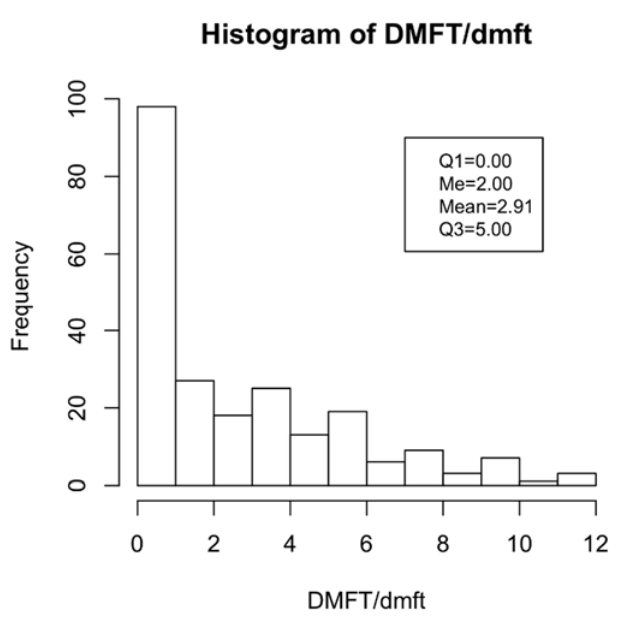
Figure 1. Histogram of the total number of decayed, missing, and filled teeth in the primary and permanent dentition (denoted by DMFT / dmft) for the 229 children in the study. Q1 = First quartile, Me = Median, Q3 = Third quartile.